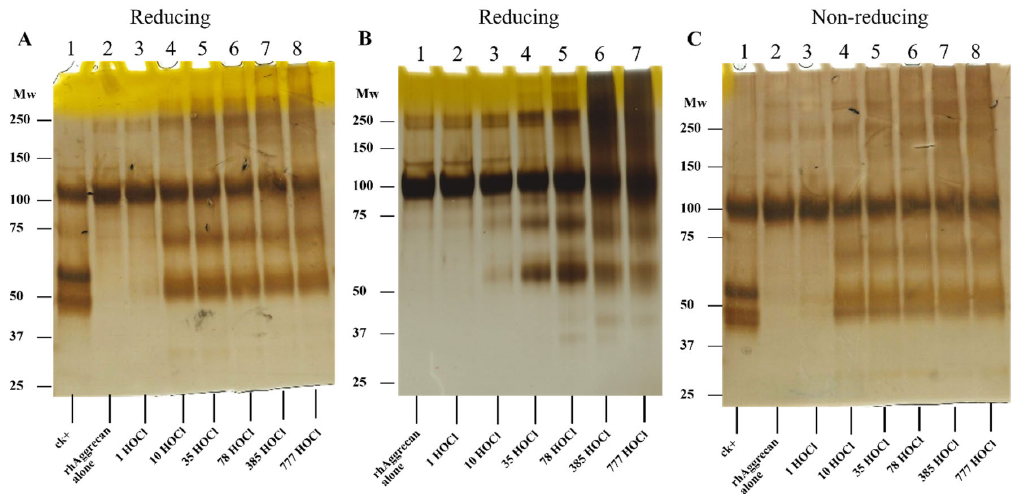
Figure 2. Effects of HOCl on rhAggrecan structure as determined by SDS ‐ PAGE. rhAggrecan (643 nM) was exposed to either 100 nM rhADAMTS1 (positive control, ck+) or 0, 1 ‐ , 10 ‐ , 35 ‐ , 78 ‐ , 385 ‐ and 777 ‐ fold molar excesses of reagent HOCl (i.e., 0, 0.7 μ M, 7 μ M, 25 μ M, 50 μ M, 247 μ M, and 500 μ M) for 24 h at 37 °C in either buffer A (panel A , C ) or in PBS (panel B ), with the protein then analysed by SDS ‐ PAGE under reducing (panels A , B ) or nonreducing condition (panel C ), with the protein bands visualized by silver staining. Molecular mass markers are indicated on the left side of each image. Images are representative data from three independent experiments.